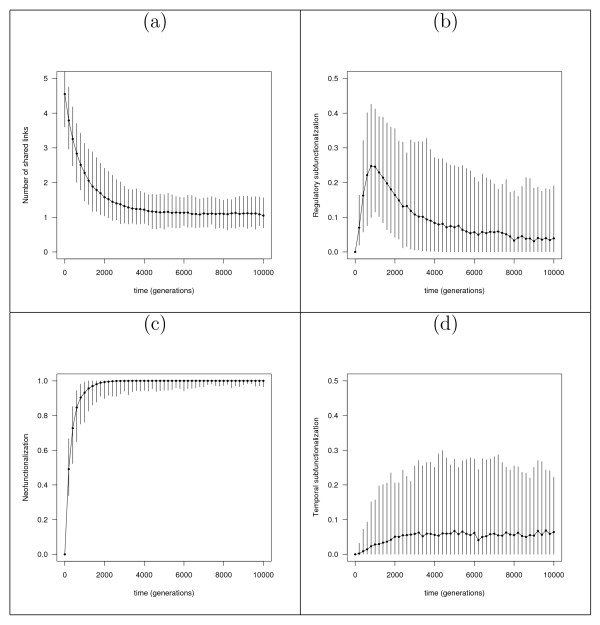
Evolution of measures over time for a particular set of conditions (c = 0.45, D = 0). (a) Number of shared regulatory elements (H) between paralogous cis-regulatory elements declines over time. (b) Regulatory subfunctionalization (see Methods – Measures for paralogous genes) as a proportion of the number of eligible genes (defined as the number of rows with two or more nonzero entries), since we need to adjust for genes with N < 2, which cannot be subfunctionalized. (c) Neofunctionalization increases monotonically, then stabilizes. (d) Temporal subfunctionalization as a proportion of the number of genes. Graphs show median values and 95% confidence interval (errorbars) over 200 independent runs.